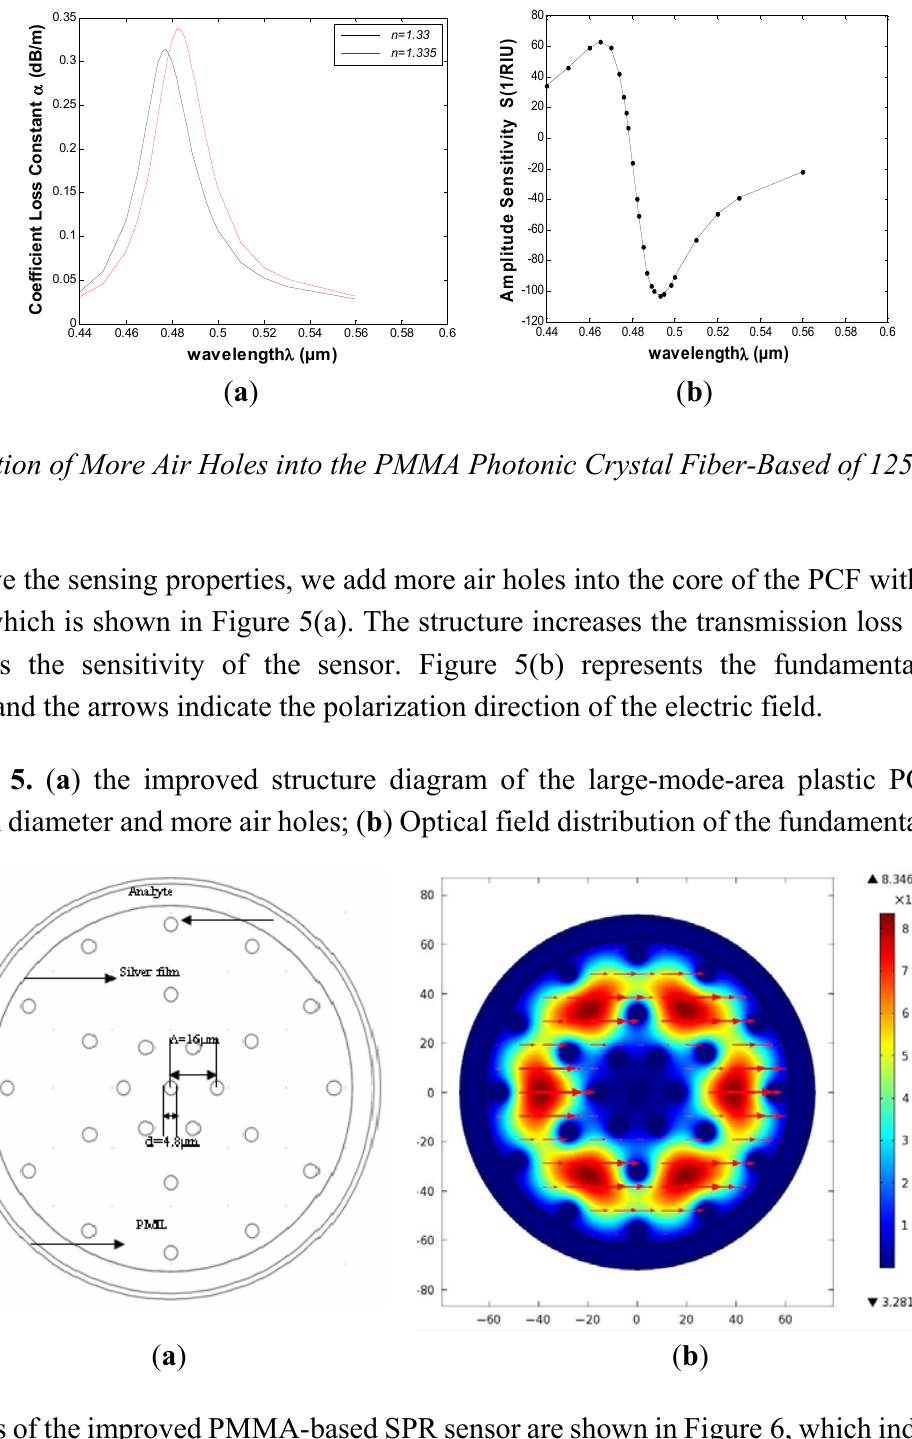
Figure 4. ( a ) Relationship between wavelength and attenuation constant of the fundamental mode of the PMMA PCF. The red and blue curves represent the refractive indices of the samples are 1.33 and 1.335 ( Δ λ peak ≈ 6 nm), respectively; ( b ) Intensity detection sensitivity curve.